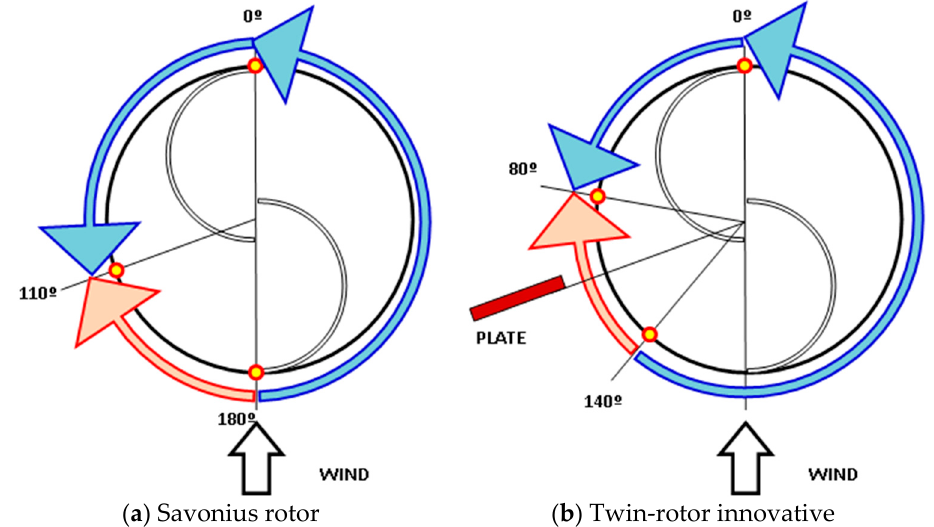
Figure 14. Propulsive (blue) and counter-propulsive (pink) action.